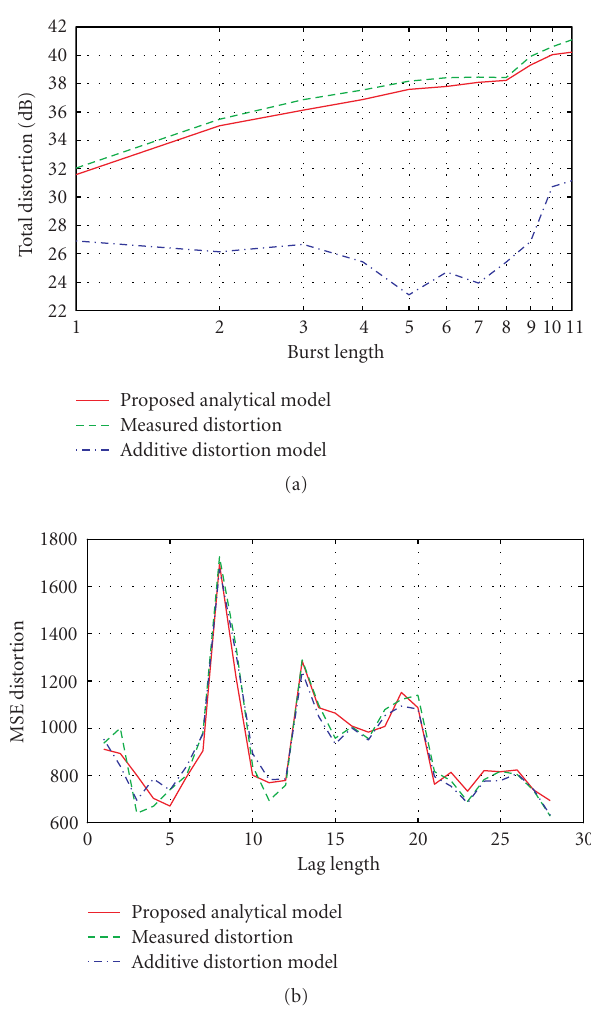
Figure 10: (a) Total distortion versus burst error length. (b) Total distortion of two losses with lag (first error frame at 38 and the sec- ond 38 + lag.)